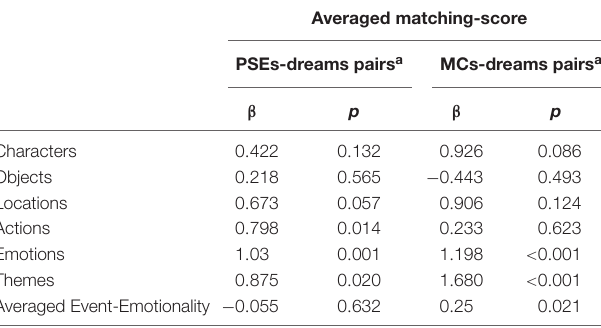
TABLE 2 | Regression analysis for the averaged Matching-score as predicted by the different kinds of averaged similar features of events-dreams pairs (characters, objects, locations, actions, emotions, themes), and the averaged